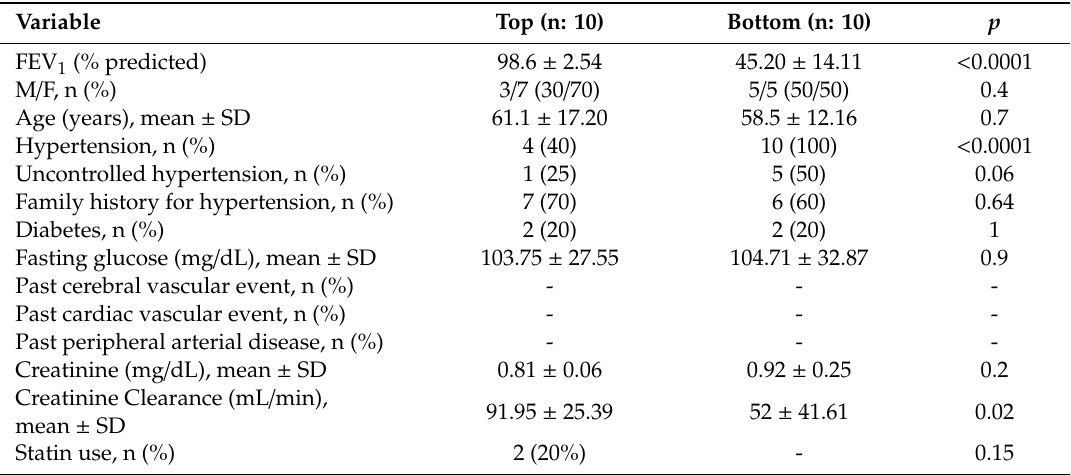
Table 4. Demographic, clinic and lab variables—asthmatics top vs. bottom levels of FEV 1.